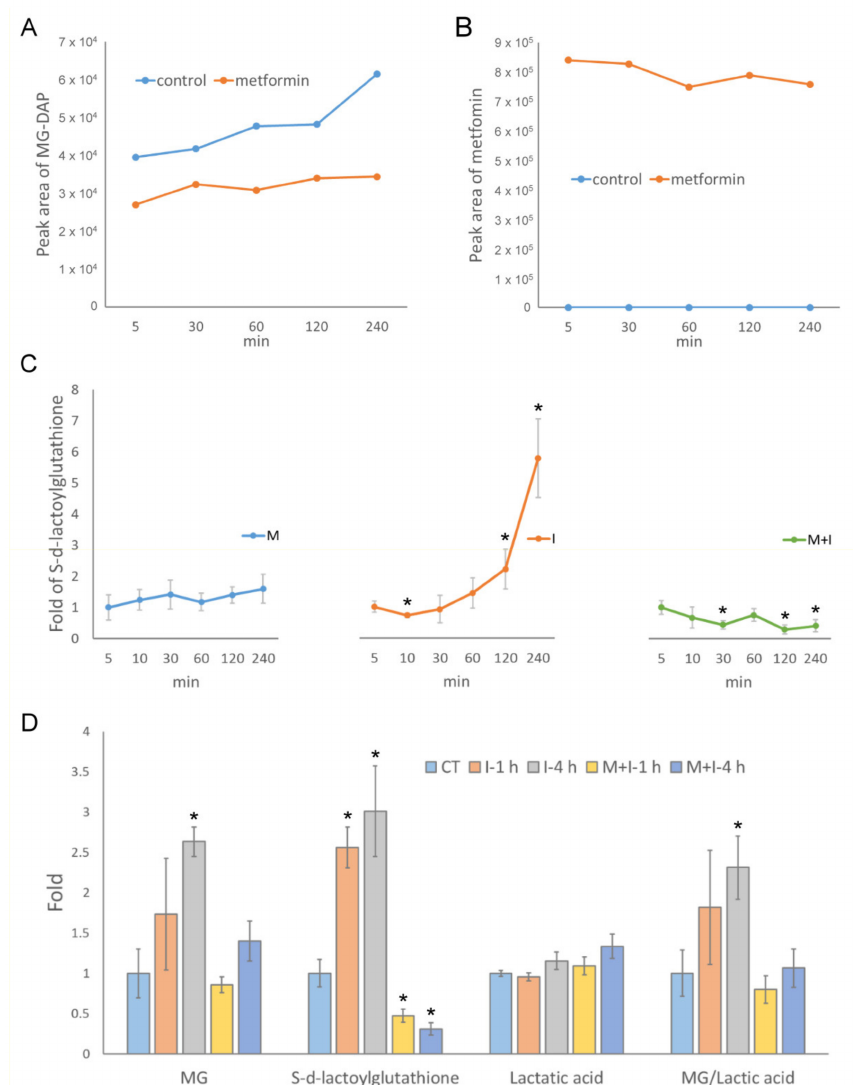
Figure 1. Methylglyoxal (MG) catabolism in metformin- and insulin-treated HEK293T cells. Detection of ( A ) MG derivative (MG-DAP) and ( B ) metformin in culture medium. ( C ) Cellular levels of S-d-lactoylglutathione were detected by LC-ESI-MS in M: 10 mM metformin, I: 10 ng/mL insulin, and M+I: 10 mM metformin + 10 ng/mL insulin-treated HEK293T cells. ( D ) Levels of cellular MG (MG: MG-DAP), S-d-lactoylglutathione, and lactic acid (lactate-ANL) were determined by LC-ESI-MS in HEK293T cells treated with I and M+I for indicated time points after treated conditions. Results significantly different from control at p < 0.05 are indicated by * ( n =